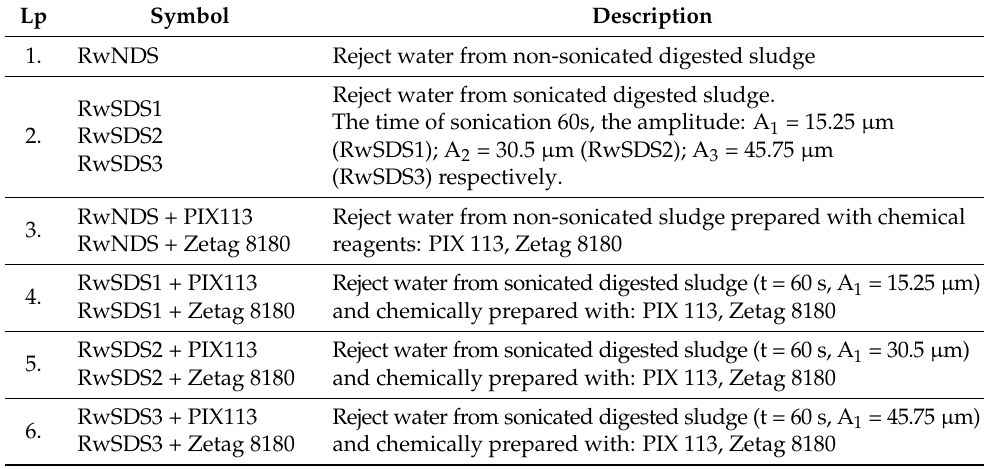
Table 2. Symbols assigned to the reject water